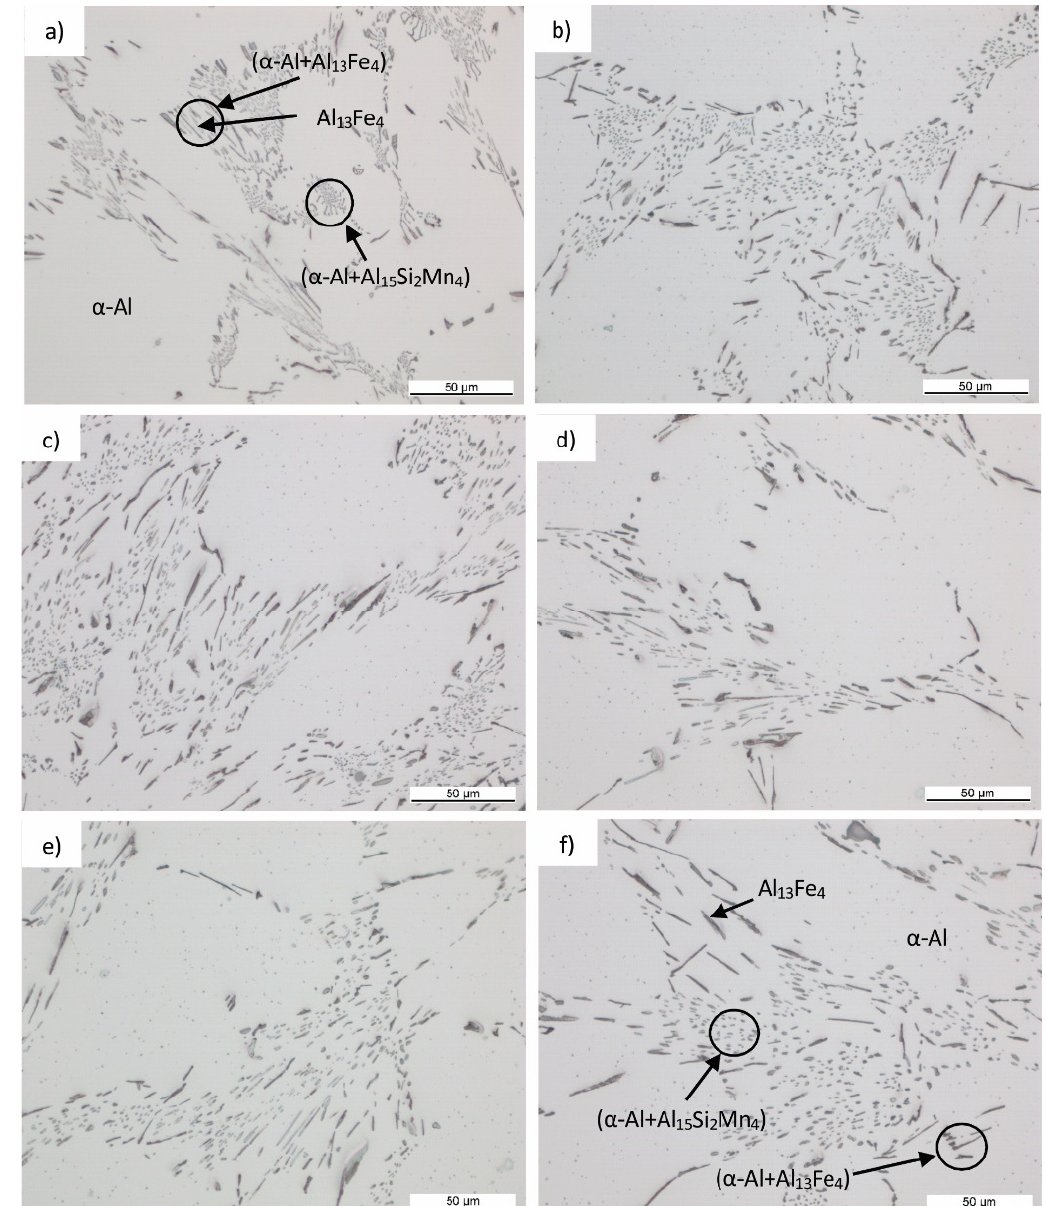
Figure 4. Microstructure of a sample in an as-cast state, and of homogenized samples at 580 °C, at 500× magnification: in an as-cast state ( a ) and after 4 h ( b ), 6 h ( c ), 8 h ( d ), 10 h ( e ) and 12 h ( f ).